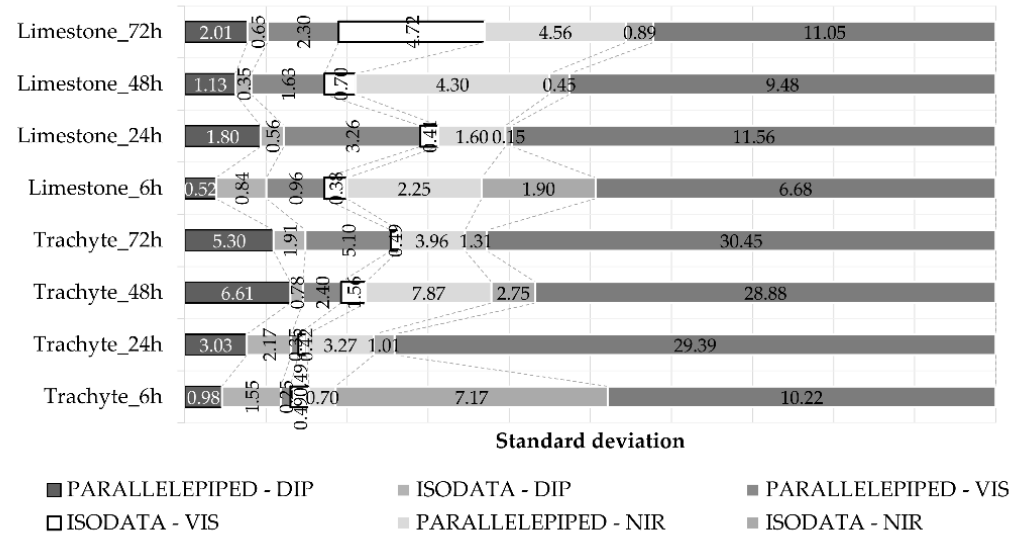
Figure 9. Standard deviation trend calculated for each mixture and technique at every rolling-bottle time test. For limestone aggregates, higher results are reached with the use of VIS-spectrometer (97.4%) and digital pictures (99.1%), respectively, using ISODATA and parallelepiped techniques. For trachytic aggregates, overall accuracies are generally lower but, similar to limestone aggregates, better accuracies are reached using VIS spectrometer (94.3%) and digital pictures (98.3%), respectively, using ISODATA and parallelepiped techniques.